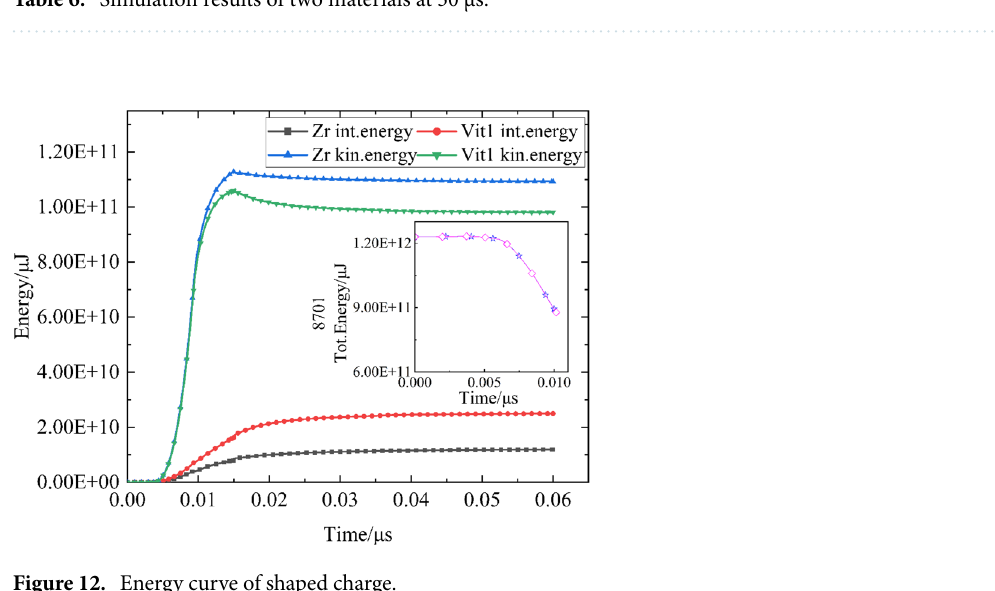
Table 6. Simulation results of two materials at 30 μs.